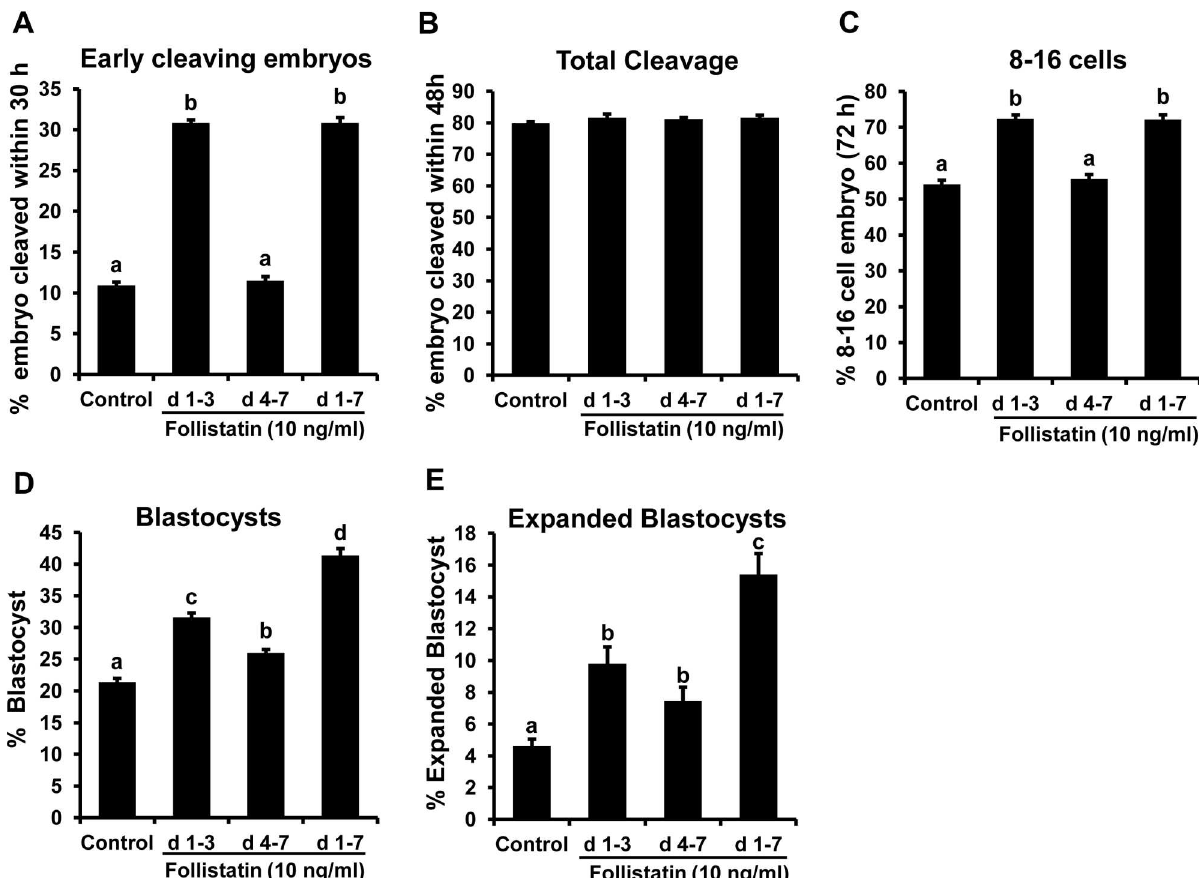
Fig 2. Stage-specific effectsof follistatin treatment on bovine early embryo development. Effect of exogenous follistatintreatment duringpre-compaction (d 1–3), peri-/post-compaction (d 4–7) and entire period(d 1–7) of in vitro embryo culture on; (A) First embryonic cleavage(30hpi). (B) Total cleavagerate (48hpi). (C) Proportionof embryos developing to the 8–16 cell stage on 3 d post insemination (pi). (D) Blastocyst rate (7 dpi). (E) Rate of expanded blastocysts (8 dpi). Valuesare shown as the mean ± SEM of the data collectedfrom 6 replicates(n = 25–30 zygotes/treatment in each replicate). Valuesaccompaniedwith different letters across the treatments indicate significantdifference (P <